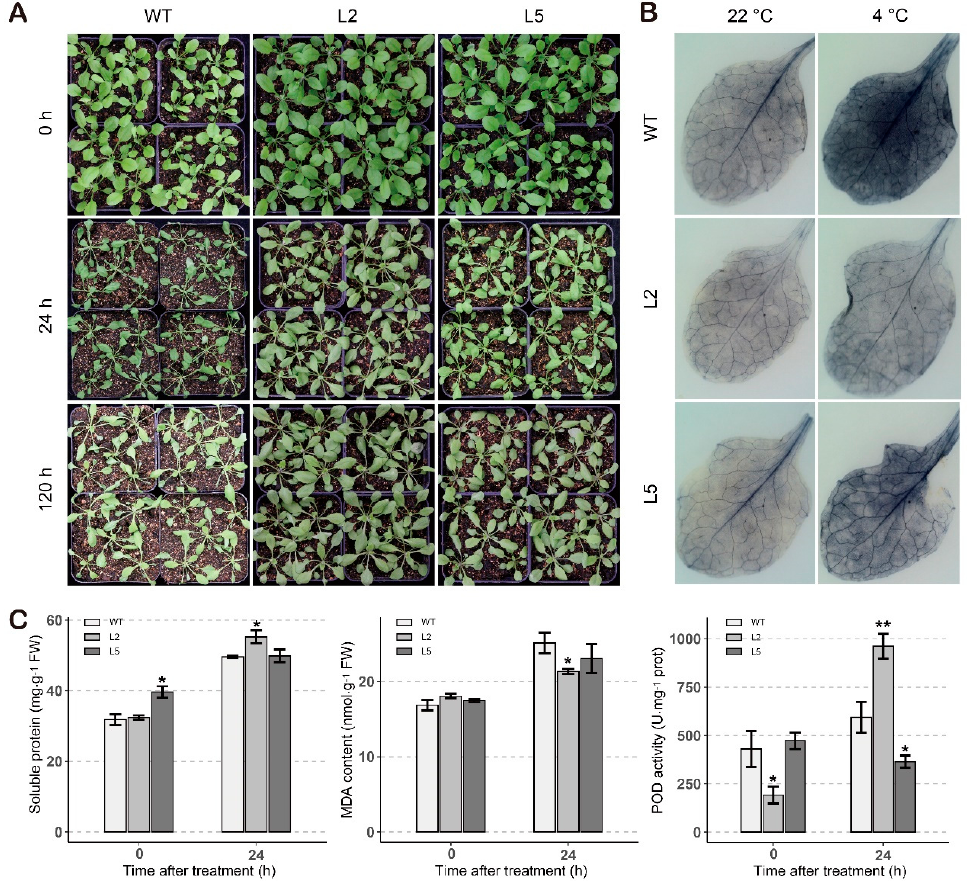
Figure 8. Overexpression of GhTIP1;1-like in Arabidopsis improves cold tolerance. ( A ) The effects of cold stress on transgenic plants and WT. ( B ) Histochemical staining assays were performed to detect O 2 ˉ by NBT staining. ( C ) Physiological indexes determination of transgenic lines and wild type plants in normal and cold environments. Each experiment was repeated three times, with the bar representing the standard error (SE). Asterisks indicate a significant difference from the WT plants at p < 0.05 or p < 0.01 as determined by Bonferroni’s Correction.